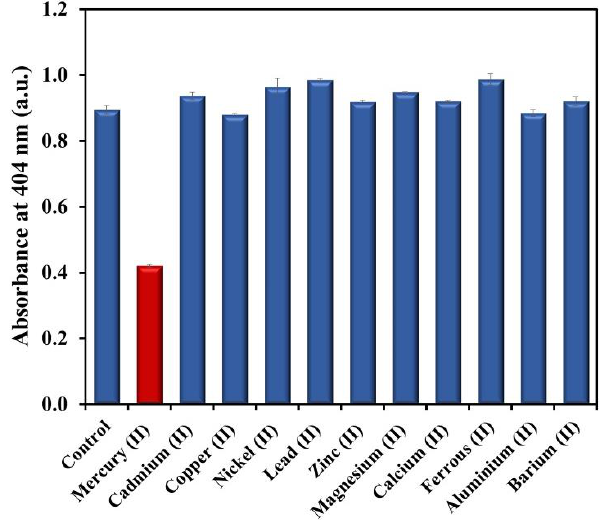
Figure 7. Selectivity study for 80 mg L − 1 mercury (II) in the presence of interfering species with the concentration 500–fold higher than those of analytes.